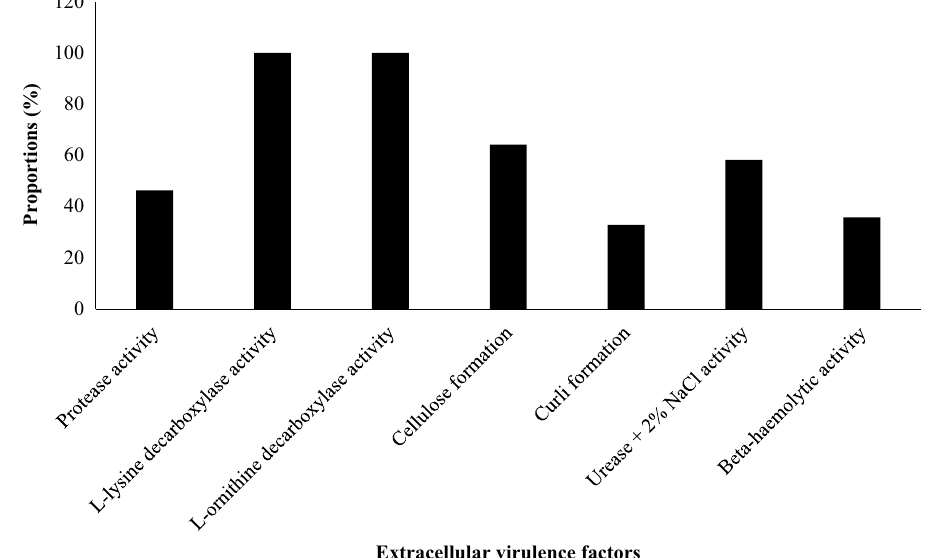
Figure 2. Extracellular virulence factors formation of V. parahaemolyticus isolates.